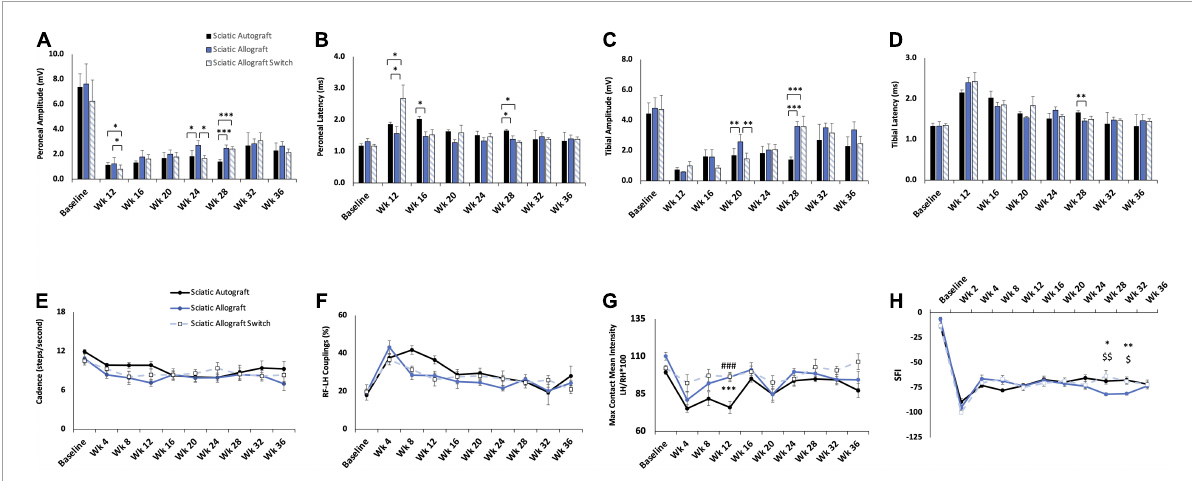
FIGURE5 Compound muscle action potential (CMAP) and gait analysis of inbred Lewis to Lewis sciatic allograft and sciatic allograft switch groups. Sciatic autograft is included for reference. (A) Amplitude recordings of the peroneal branch of the sciatic nerve. (B) Latency recordings of the peroneal branch of the sciatic nerve. (C) Amplitudes recorded from the tibial branch of the sciatic nerve. (D) Latencies of the tibial branch of the sciatic nerve. ∗ p < 0.05, ∗∗ p < 0.01, ∗∗∗ p < 0.001. (E) Cadence in steps per second as calculated by the CatWalk software. (F) RF-LH coupling showing the percentage of time the left hind (LH) paw preceded the right front (RF) paw in the step cycle. (G) Measure of the maximum intensity at the point of maximum contact for the left hind paw/right hind paw*100. (H) Sciatic functional index (SFI) recordings as calculated by the CatWalk software. n = 5 for autograft group and n = 6 for inbred sciatic allografts in both orientations. ∗ p < 0.05, ∗∗ p < 0.01 between sciatic autograft and sciatic allograft, ### p < 0.001 between sciatic autograft and sciatic allograft switch, $ p < 0.05, $$ p < 0.01, $$$ p < 0.001 between sciatic allograft and sciatic allograft switch. All statistical analysis were repeated measures ANOVA with Tukey post hoc test. Error bars are